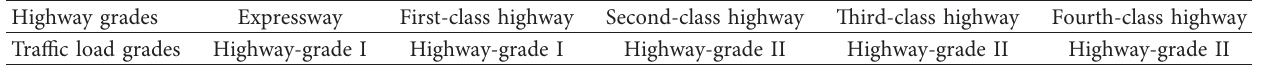
Table 2: Traffic load grades of the bridges for different highway grades in JTG D60-2004. Highway grades